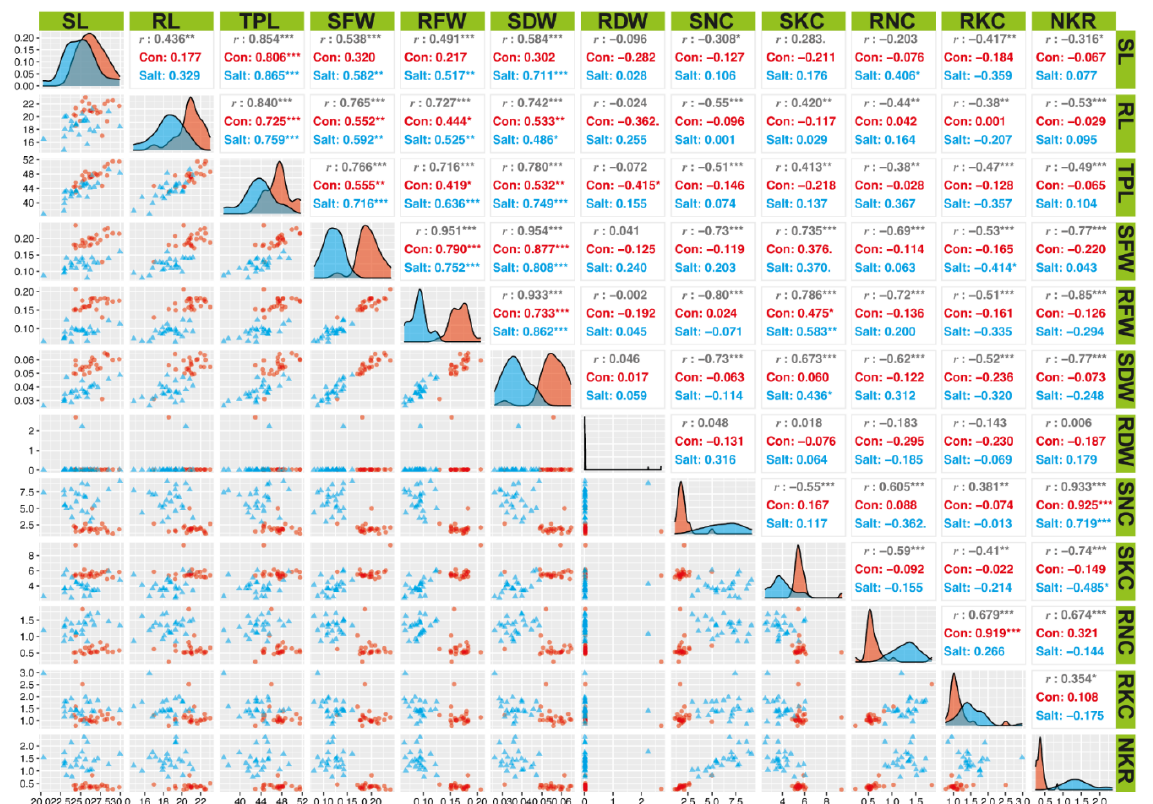
Figure 2. Correlation between 12 morpho-physiological traits of rice genotypes at seedlings stage. Plants were evaluated in control (Con) and 200 mM salt stress (Salt). SL = shoot length (cm); RL = root length (cm); TPL = total plant length (cm); SFW = shoot fresh weight (g); RFW = root fresh weight (g); SDW = shoot dry weight (g); RDW = root dry weight (g); SNC = shoot sodium (Na + ) concentration; SKC = shoot potassium (K + ) concentration; RNC = root Na + concentration; RKC = root K + concentration; NKR = whole plant sodium/potassium (Na + /K + ) ratio. *** Highly significant ( p < 0.001); ** Highly significant ( p < 0.01); * significant ( p < 0.05).